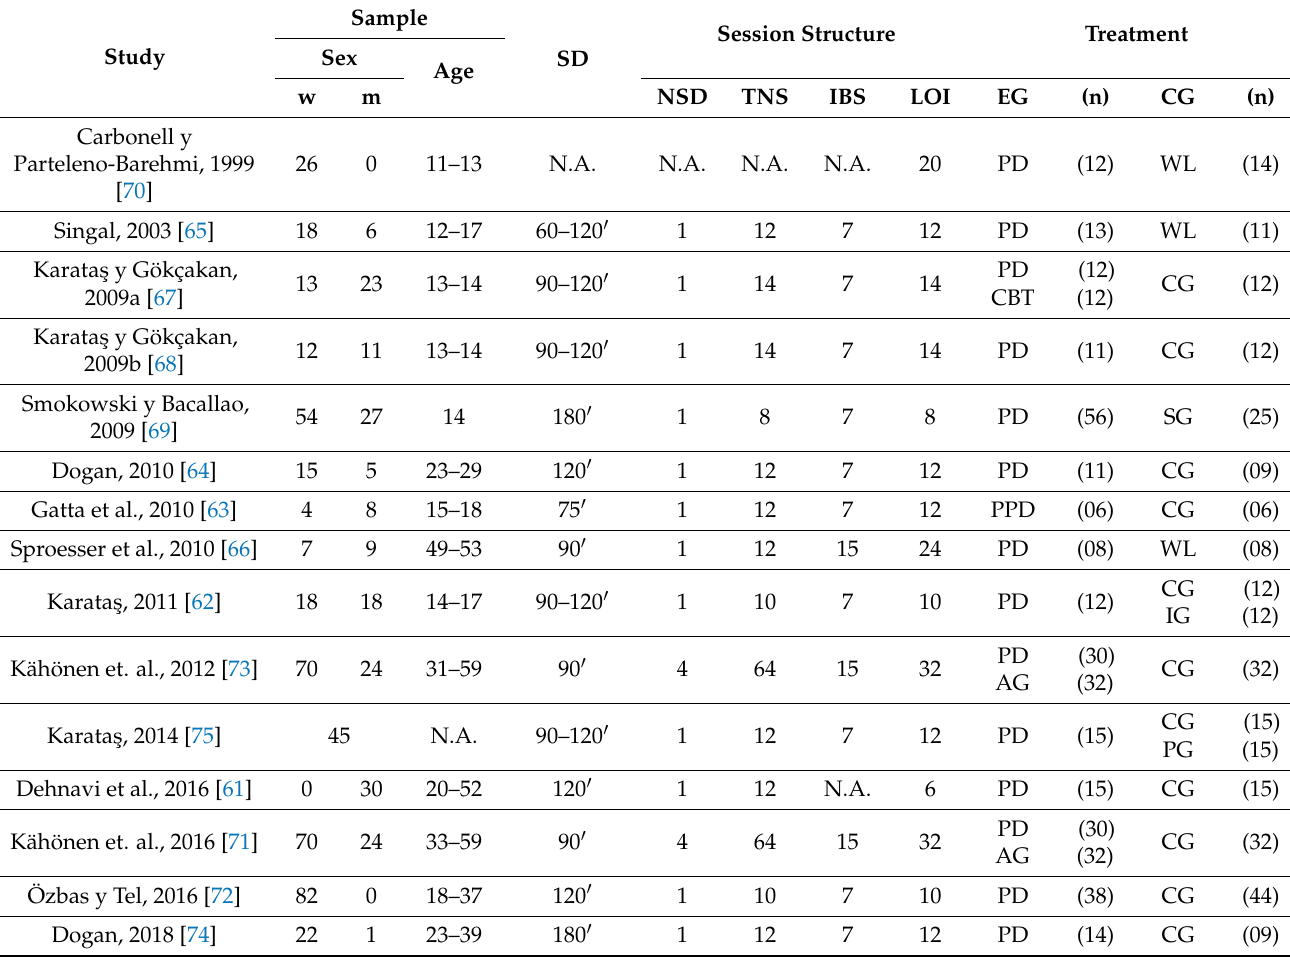
Table 4. Substantive variables of the sample (age and sex), structure of the sessions (number and duration, interval between sessions, and length of the intervention) and type of